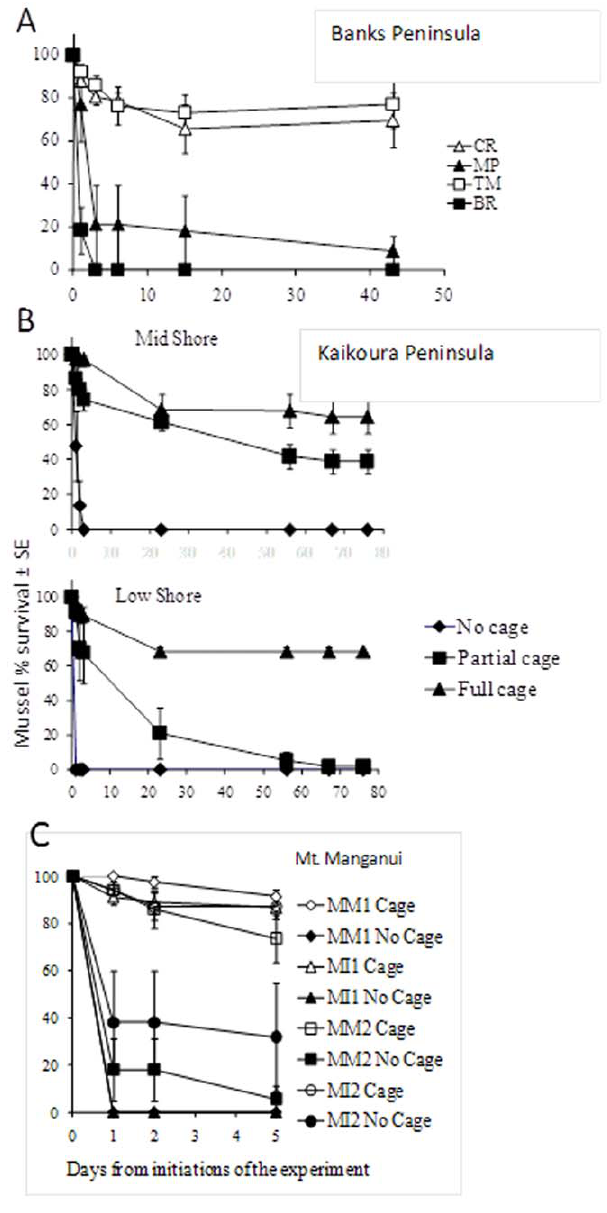
Figure 2. Effect of predation on mussel survival rates on R-S and R-R sites. (a) Banks Peninsula (sites: R-S=CR, TM, and R-R=MP, BR), only no-cage treatment and only low-shore level. (b) Kaikoura Peninsula, R-R site, low- and mid-shore levels, full cage control, partial cage and no cage treatments. (c) Mt. Maunganui, four sites (two R-S: MM2, MI2 and two R-R: MM1, MI1), both cage control and no-cage treatment; only low-shore level. Blank symbols=R-S sites, black symbols=R-R sites. Day 0=day mesh was removed and mussels on tiles placed in the experimental treatments.